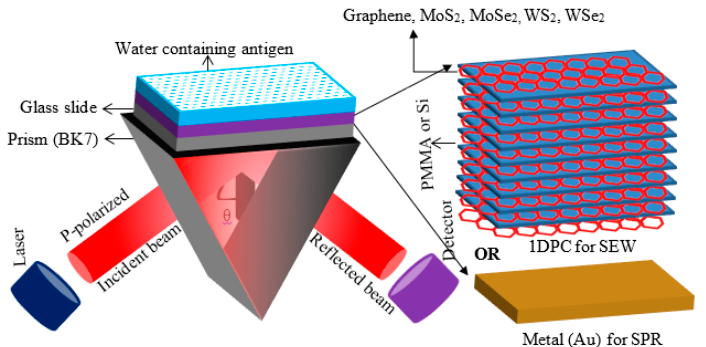
Figure 1. Schematic of the prism-based structure of the Au-surface plasmon resonance (SPR) sensor and the proposed one-dimensional photonic crystal (1DPC) sensor.